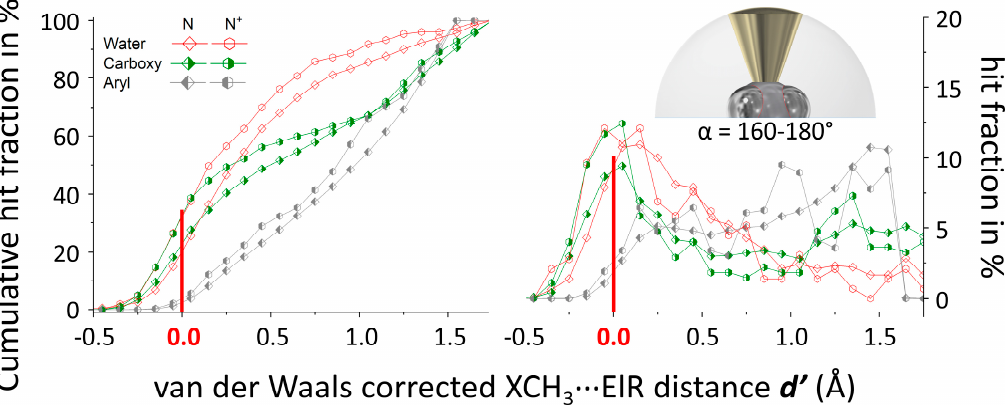
Figure 4. Cumulative ( left ) and regular ( right ) hit fraction (in %) as a function of the van der Waals corrected XCH 3 ∙∙∙ ElR distance d’ (in Å) for the datasets from Table S2 ( α = 160°–180° as illustrated in the inset figure). The interacting pairs involve water-O (red, empty), carboxy-O (green, right-filled) or the centroid of an aryl ring (grey, left-filled). X can be any N (diamond) or a cationic (tetravalent) N + (hexagonal). N (N / N + ) = 1,809 / 290 (water, red); 2,062 / 274 (carboxy, green); 10,585 / 527 (aryl, grey).